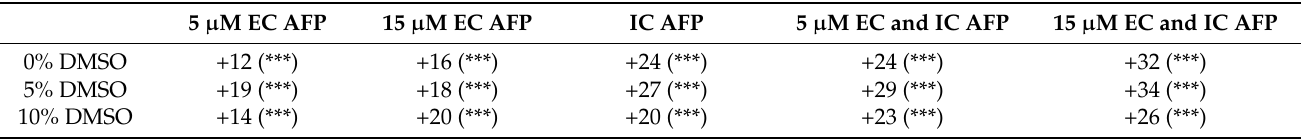
and intracellular (IC) AFP vs. cells without AFP (untransfected), as determined by trypan blue assay.